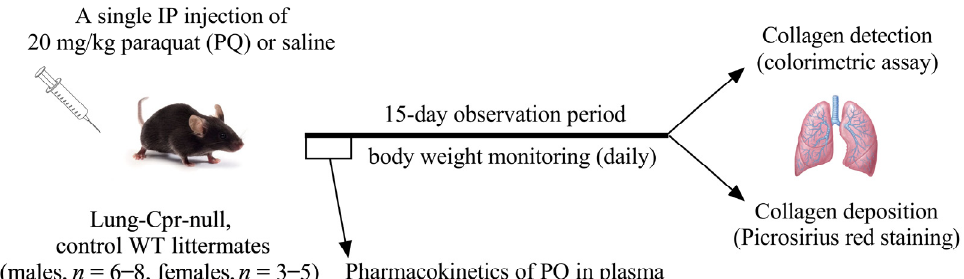
Figure 1. Experimental design to evaluate paraquat (PQ)-induced collagen deposition in the mouse lung. PQ or saline was administered as a single intraperitoneal injection to lung- Cpr -null and WT control littermates, male and female. Animals were sacrificed on day 15 after the injection, for harvesting of the lungs for colorimetric analysis and histopathological determinations of collagen deposition. A separate set of lung- Cpr -null and WT control littermate mice were used for determination of PQ in plasma following a single intraperitoneal injection of 20 mg/kg PQ. For toxicokinetic studies, blood samples were collected from PQ-treated males ( n = 4) and females ( n = 3) via the tail vein using heparin-coated capillary tubes, at 0.25, 0.5, 1, 2, 4, and 8 h following PQ injection (at 20 mg/kg, i.p.). Plasma, prepared by centrifugation